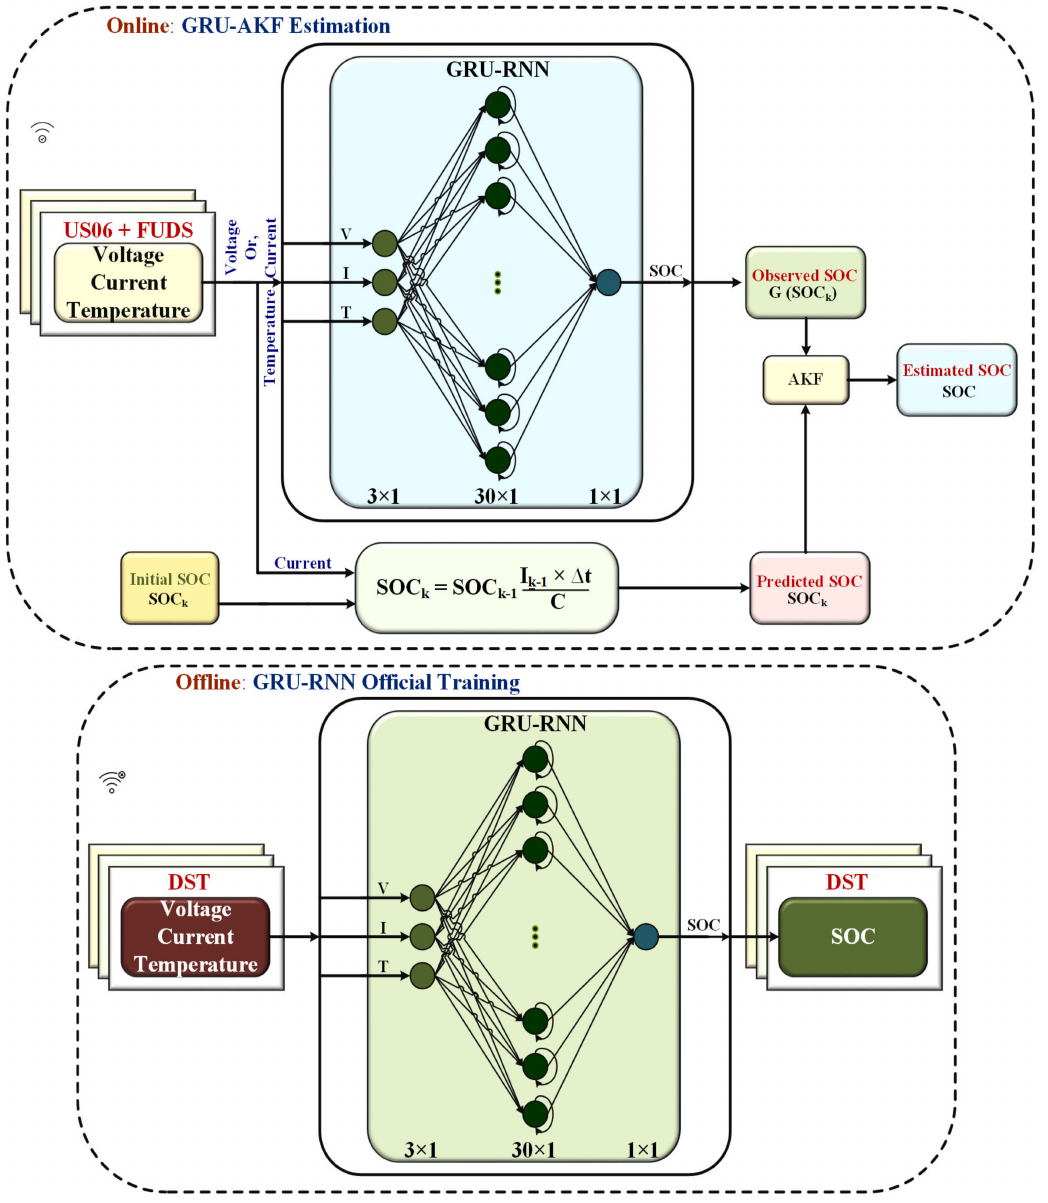
Figure 7. Hybrid GRU-AKF model-based SOC estimation